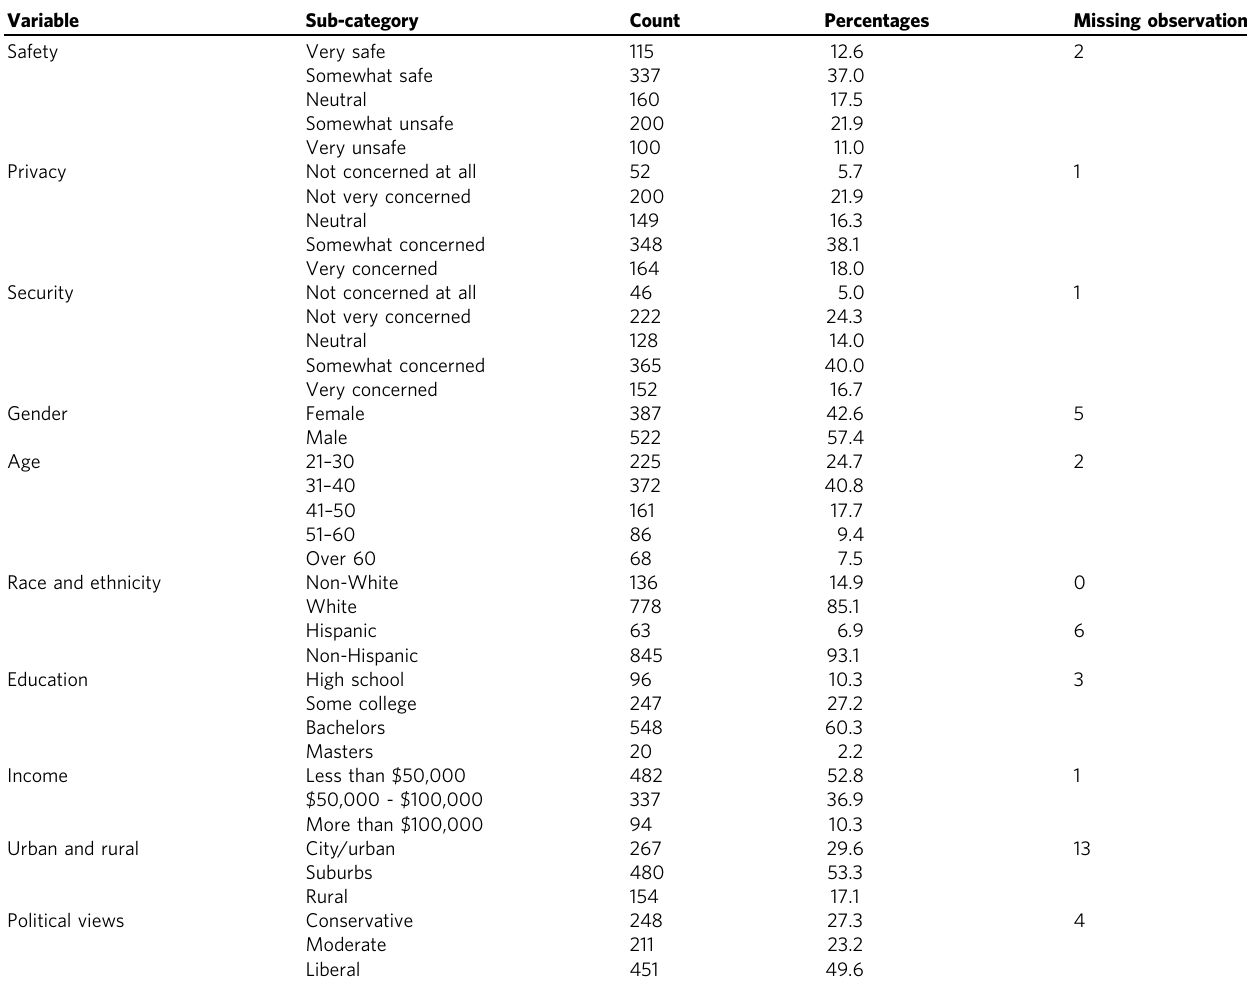
Table 1 Descriptive statistics.